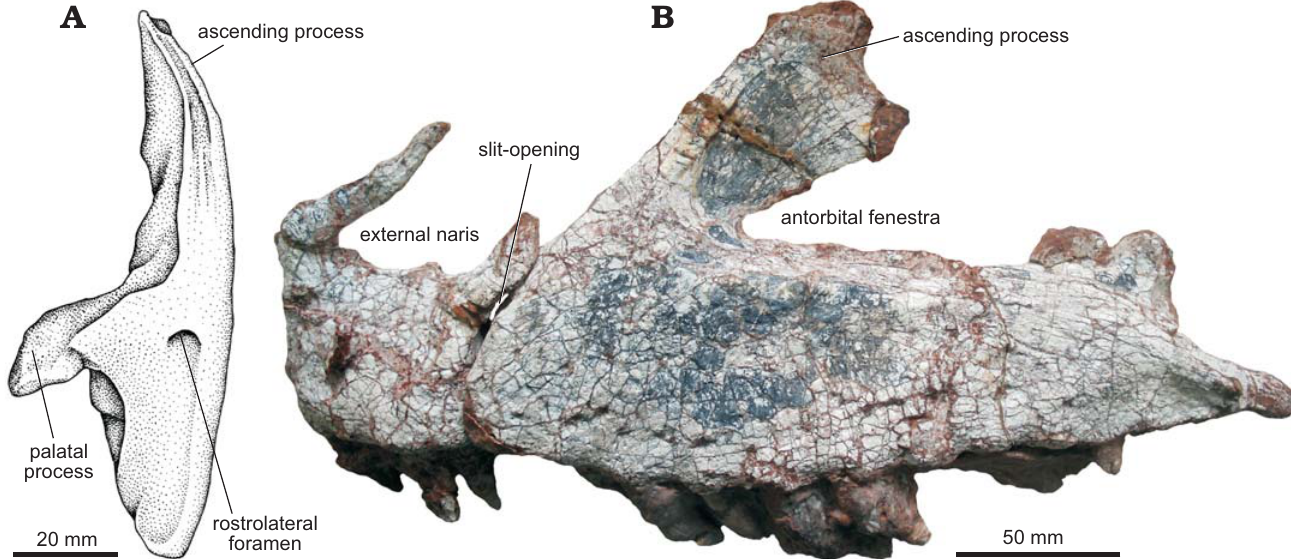
Fig. 6. The pseudosuchian archosaur Prestosuchus chiniquensis Huene, 1938 (UFRGS-PV-0629-T) from the Dinodontosaurus Assemblage Zone, Ladinian, Middle Triassic, Dona Francisca municipality, Rio Grande do Sul State, Brazil. A . Explanatory drawing of the left maxilla in anterior view. B . Photograph of the articulated left premaxilla and maxilla in lateral view exhibiting a slit-opening between both